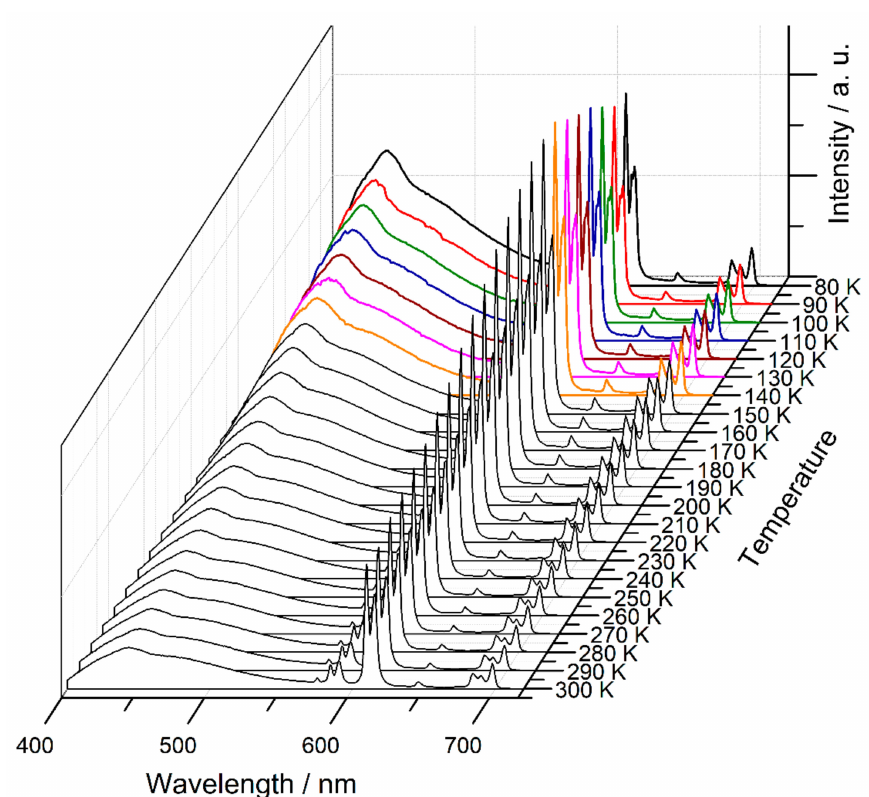
Figure 8. Temperature dependent emission spectra of 7 upon excitation at 375 nm. The spectra in the temperature region between 80 and 140 K are highlighted to emphasize the increase in Eu 3 + -based emission with rising temperature (see main text).